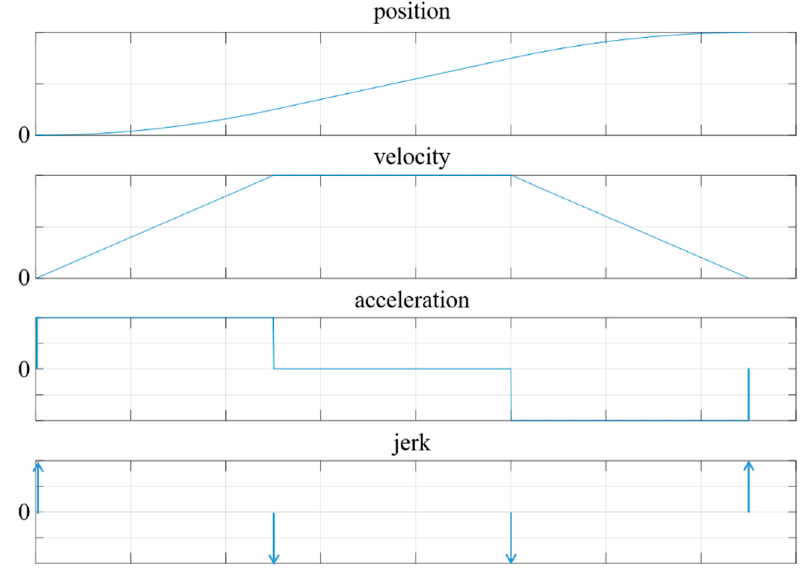
Figure 3. Trapezoidal motion profile.